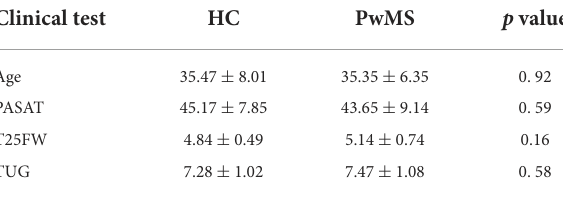
TABLE 1 Comparison of the initial clinical evaluation between patients with MS and healthy controls. Clinical